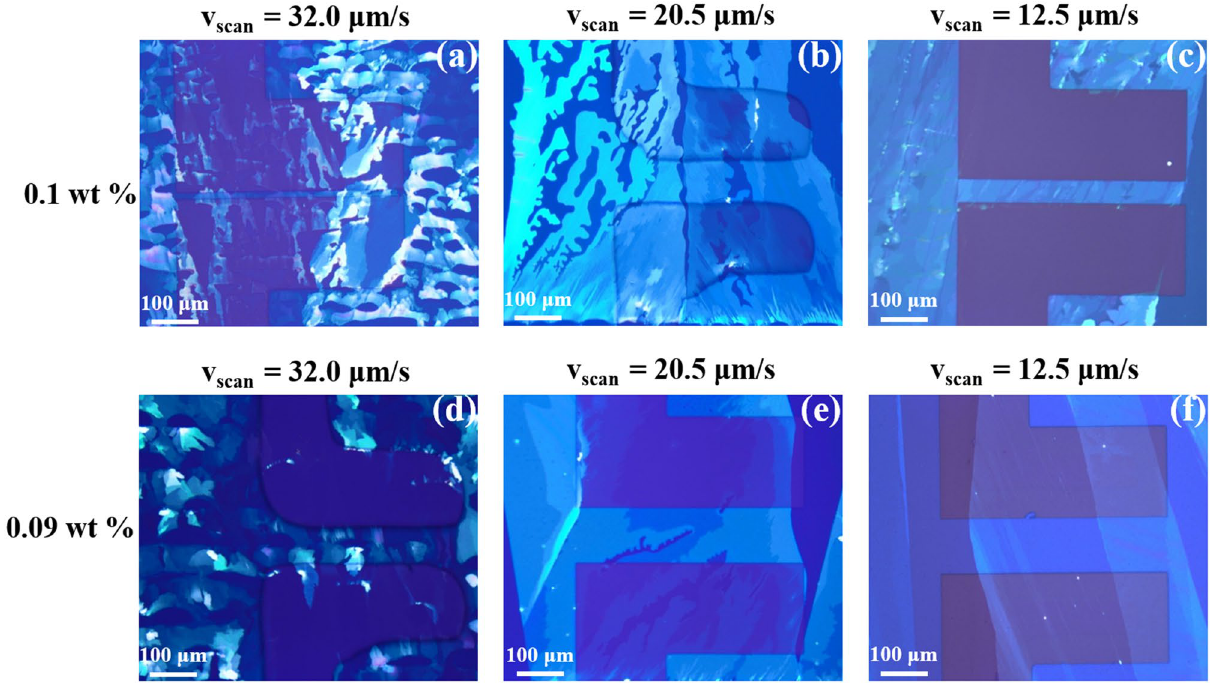
Figure 2. Characterization of 4H–21DNTT films deposited from solution shearing at different blade scanning speed ( a – c ) Polarized microscopy images of 4H–21DNTT film at 0.1 wt% concentration in o-DCB solution ( d – f ) Polarized microscopy images of 4H–21DNTT film at 0.09 wt% concentration in o-DCB